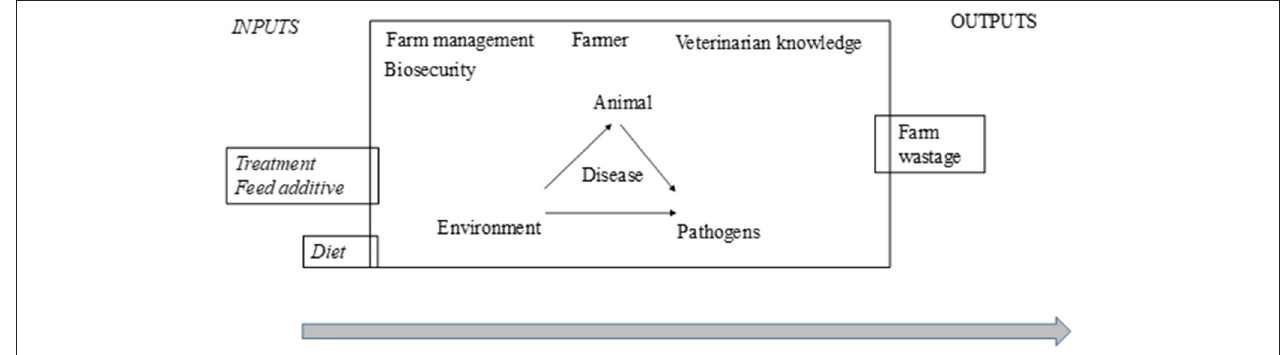
FIGURE 6 | Variability accumulated in the different components or actors when using phytotherapy in farm practice. This overview of variation accumulated from the efficacy and effectiveness of phytotherapy could be converted into the prerequisites that are needed for the manageability of phytotherapy as a therapy